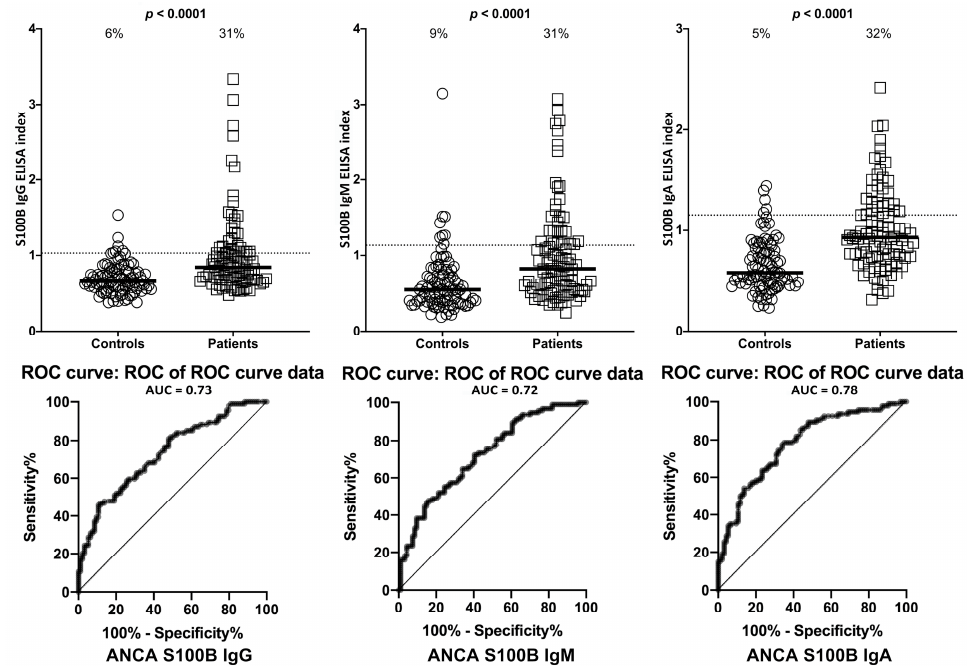
Figure 7. Percentage of elevation of IgG, IgM, and IgA antibodies against zonulin + occludin in 94 patients positive for ANCA and in 94 healthy controls. Dotted lines indicate the cutoff for positivity used in each assay, as calculated by ROC analysis. The percentage of elevation is indicated on top of each distribution, while bars indicate the corresponding median. The AUC for zonulin + occludin IgG was 0.76, 0.71 for zonulin + occludin IgM, and 0.75 for zonulin + occludin IgA.